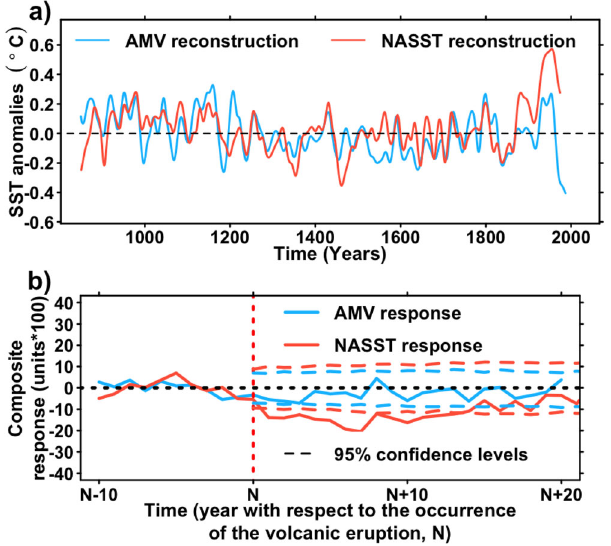
Fig. 3 | Comparison of the Atlantic Multidecadal Variability (AMV) with North Atlantic Sea Surface Temperature (NASST) and volcanic forcing. a Final reconstructions of AMV and NASST in sea surface temperature anomalies (°C). b Superposed epoch analysis 45 for responses of the AMV and NASST reconstruc- tions to the ten largest eruptions 58 of the last millennium (see Supplementary Table 5). Composite series are performed for 31 years, with the 11th year being the year of the eruptions. Each individual response is centered to its values 10 years before the eruption (fromN-10to N-1, whereN describes the yearof occurrenceof the eruption) before computing the composite time series. 95% con fi dence levels have been calculated using a Monte-Carlo approach 45 .